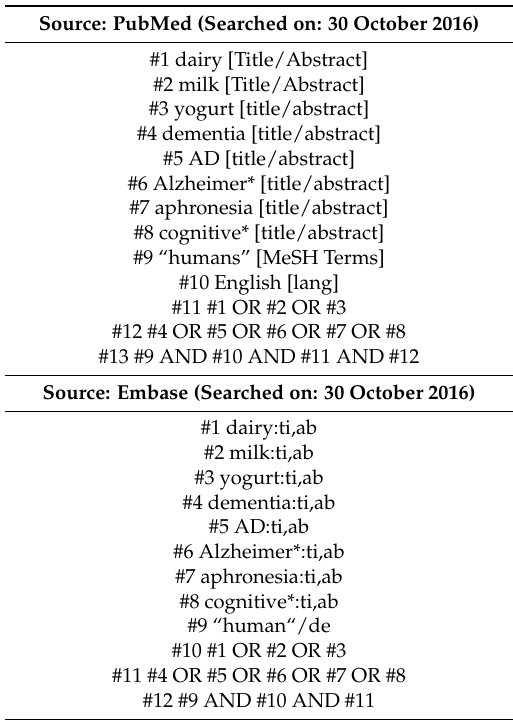
Table A1. Search strategy.